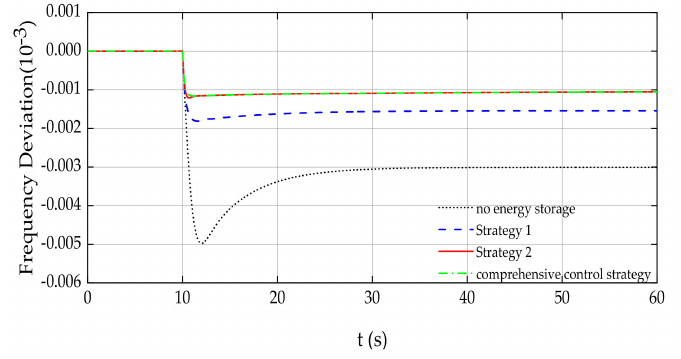
Figure 9. Frequency deviation curve under step load disturbance.